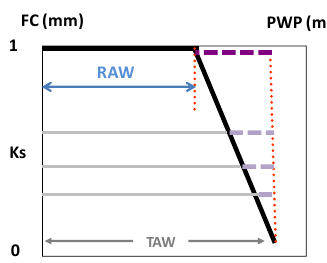
Figure 2. Ks function (black line) as the relationship between the decreasing stress coefficient (Ks) and the increasing soil water depletion (SWD, horizontal lines) in the volume explored by roots (mm), considering the range between field capacity (FC) and permanent wilting point (PWP); the dashed horizontal lines represent the decreasing difference between SWD and total available water (TAW), i.e., the water remaining in soil, which, divided by the difference TAW-RAW (upper dashed line), provides an estimation for Ks, as considered in Equation (2) [29]. From Ferreira et al. [77]. If a threshold value is known, a well-adjusted Ks function established in terms of SWD (in mm or in percentage of TAW or RAW) is able to give an answer to the questions of when and how much and can be auto-sufficient in the sense that there is no need for in situ measurements, apparently solving the problem described above (representative measurements), as already exemplified [19,78].